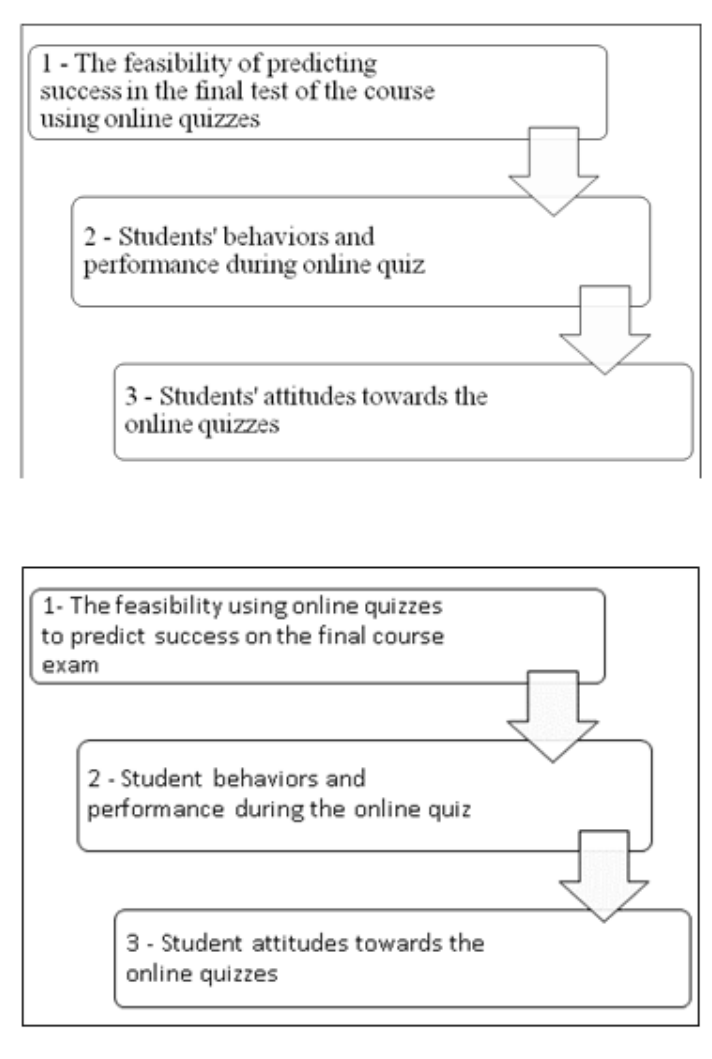
Figure 1. Investigation